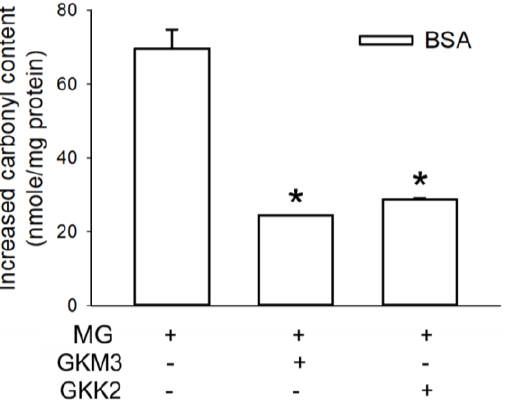
Figure 4. Effect of GKM3 and GKK2 on the content of carbonyl groups of products in the final stage of protein glycation. Data unit was expressed as the increased nmole of carbonyl groups per mg of protein of samples. Data shown are means of results calculated by values of glycated BSA groups minus values of native BSA groups obtained from three independent experiments. * means statistical differences vs. data of the group of BSA treated with MG only.